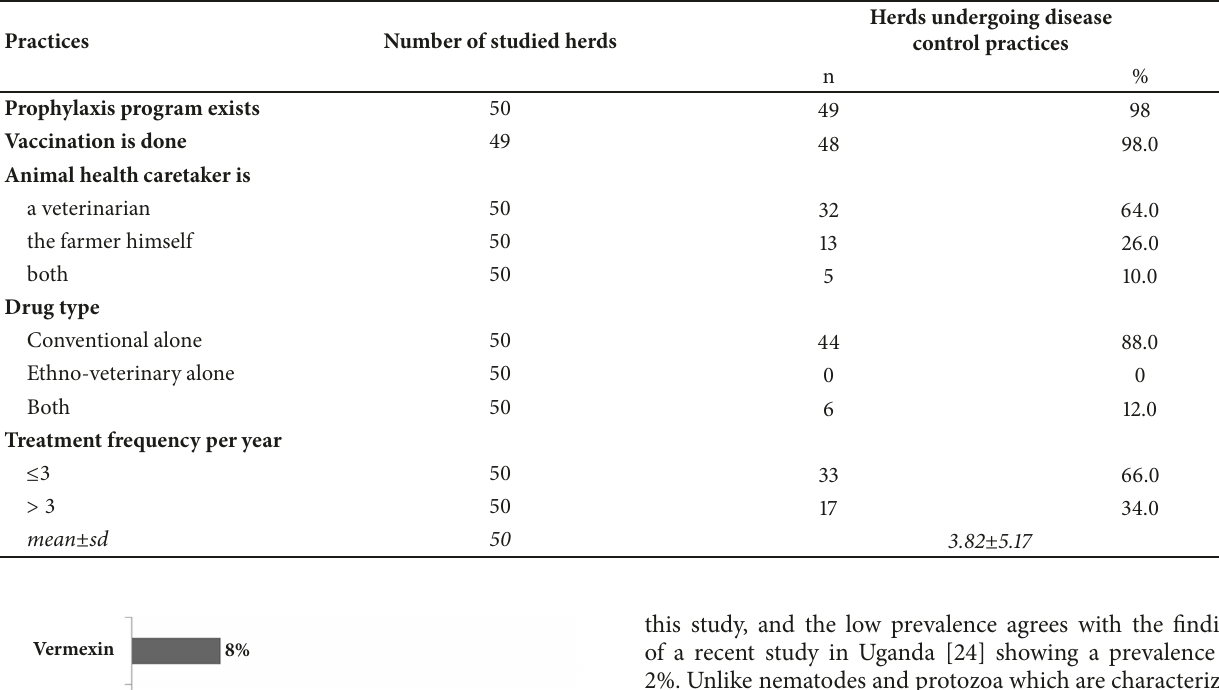
Table 3: Distribution of pig herds according to disease control practices in Bamboutos, Cameroon.